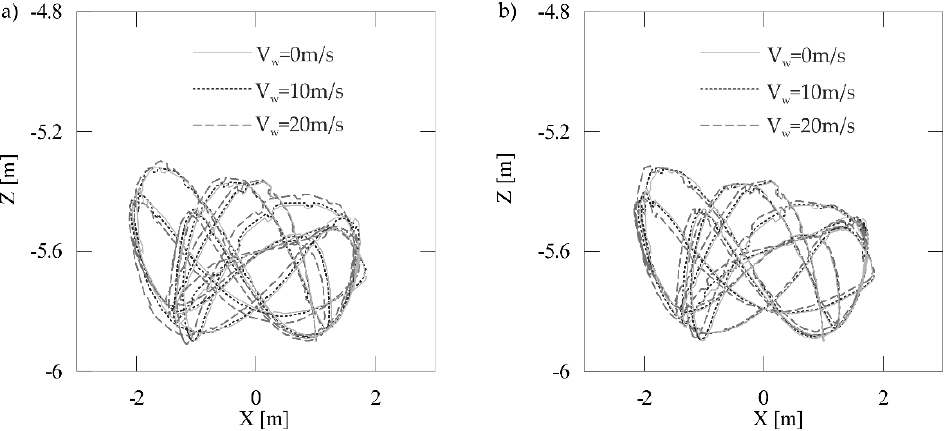
Figure 16. Projection of the trajectory of the carried load’s suspension point on one of the lifting planes for ( a ) the variable effective area and ( b ) fixed effective area.